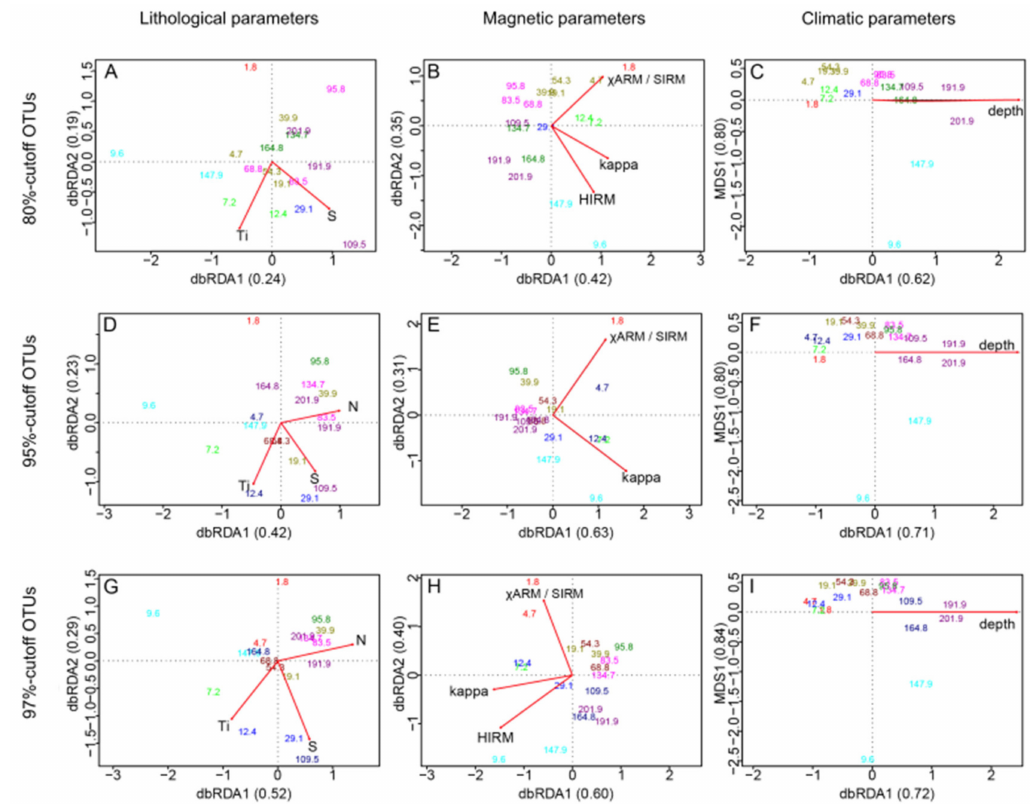
Figure 9. Correlation analysis of OTU distribution and environmental variables as defined using db-RDA and ANOVA test [1,2]. Panels ( A – C ): using 80% similarity OTU cuto ff , ( D – F ): using a 95% similarity OTU cuto ff , and panels ( G – I ) using a 97% similarity OTU cuto ff . Left column shows lithological parameters, central column shows magnetic parameters and right color shows simulated climatic parameters. Only variables that showed significance through ANOVA tests are displayed. The color code is defined by cluster analysis and provided in Figure